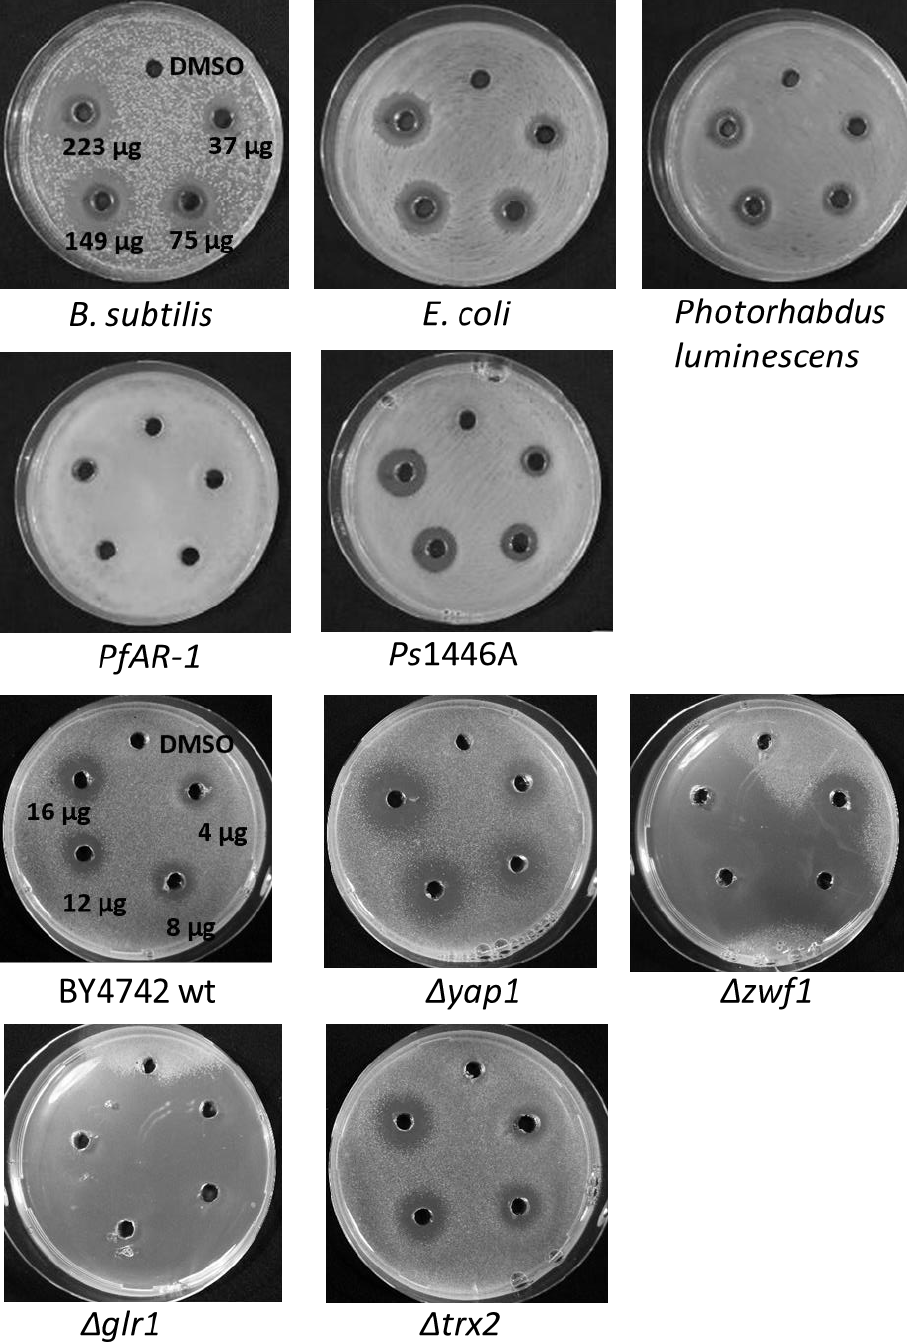
Figure 2. CSA ( S -allyl- S -( S -allyl)- N -cyanosulfilimine) inhibits the growth of bacteria and yeast. Bacteria were spread on the surface of the agar medium and 20 µ L of 10, 20, 40, and 60 mM CSA in dimethylsulfoxide (DMSO) pipetted into wells cut out of the agar, giving total amounts of 37, 75, 149, and 223 µ g CSA, respectively. For the wildtype yeast strain BY4742 and the ∆ yap1 , ∆ zwf1 , ∆ glr1 , and ∆ trx2 mutants, 20 µ L of 1, 2, 3, and 4 mM CSA in DMSO was used, giving total amounts of 4, 8, 12, and 16 µ g, respectively. The control was 20 µ L of